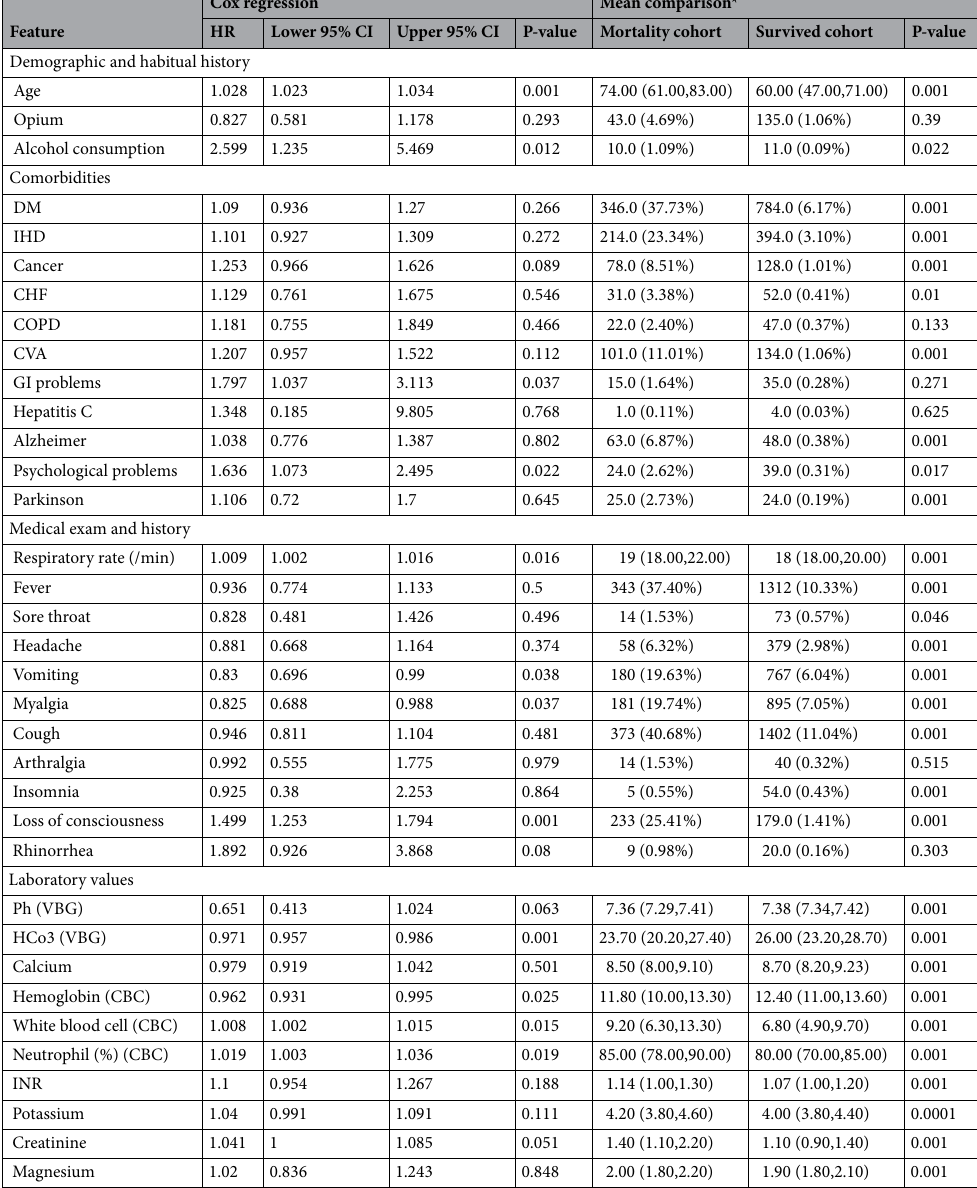
Table 2. Mean comparison and Cox regression of selected variables for inclusion in the model. VBG venous blood gas, DM diabetic mellites, INR international normalized ratio, CBC complete blood count, IHD ischemic heart disease, CHF chronic heart failure, COPD chronic obstructive pulmonary disease, CVA cerebrovascular accident. *Mann–Whitney U test was performed for evaluating difference in mean